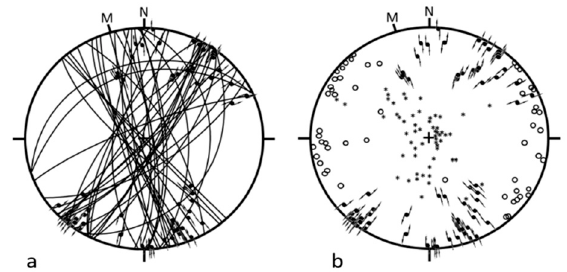
Figure 7. Regime 6–7. Lower Hemisphere Equal Area projection of great circles of fault planes ( a ); and ( b ) of poles to fault planes (open circles) and of calculated trend and plunge (*) of σ 2 . Symbols are as in Figure 3.